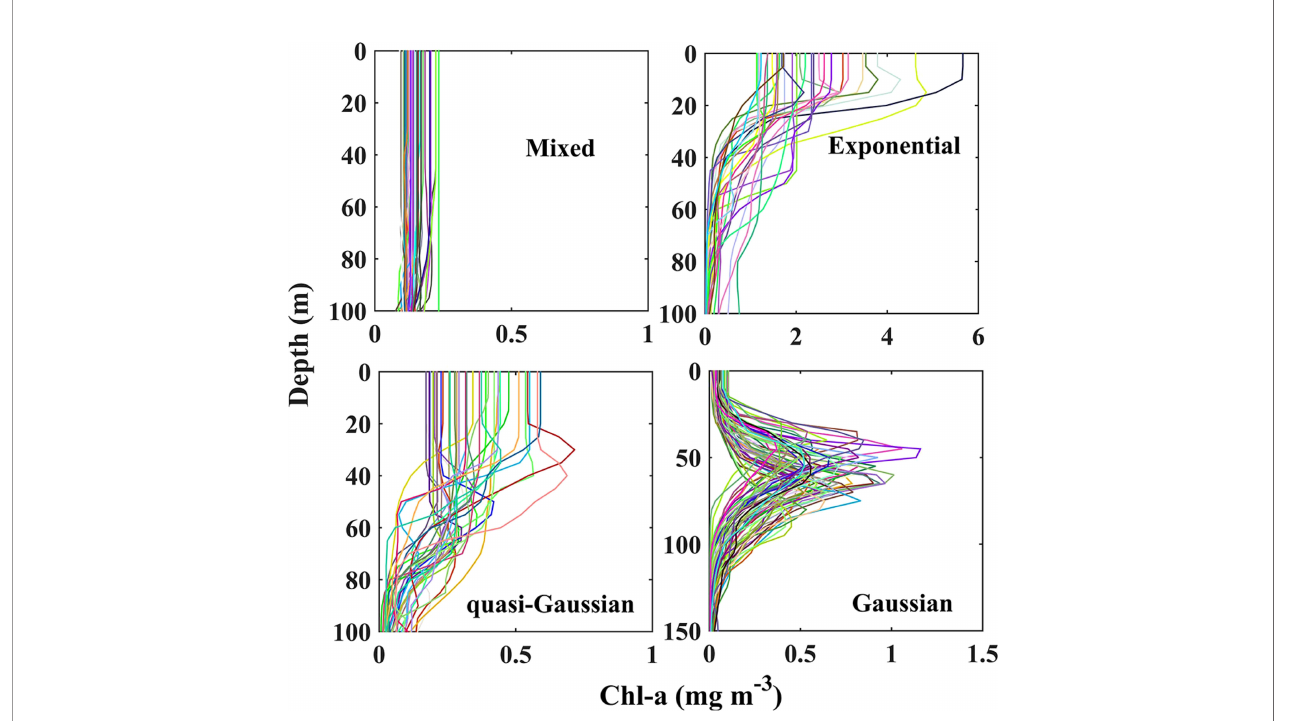
FIGURE 3 | Typical shapes for each type of Chl-a vertical pro fi le in the Mediterranean